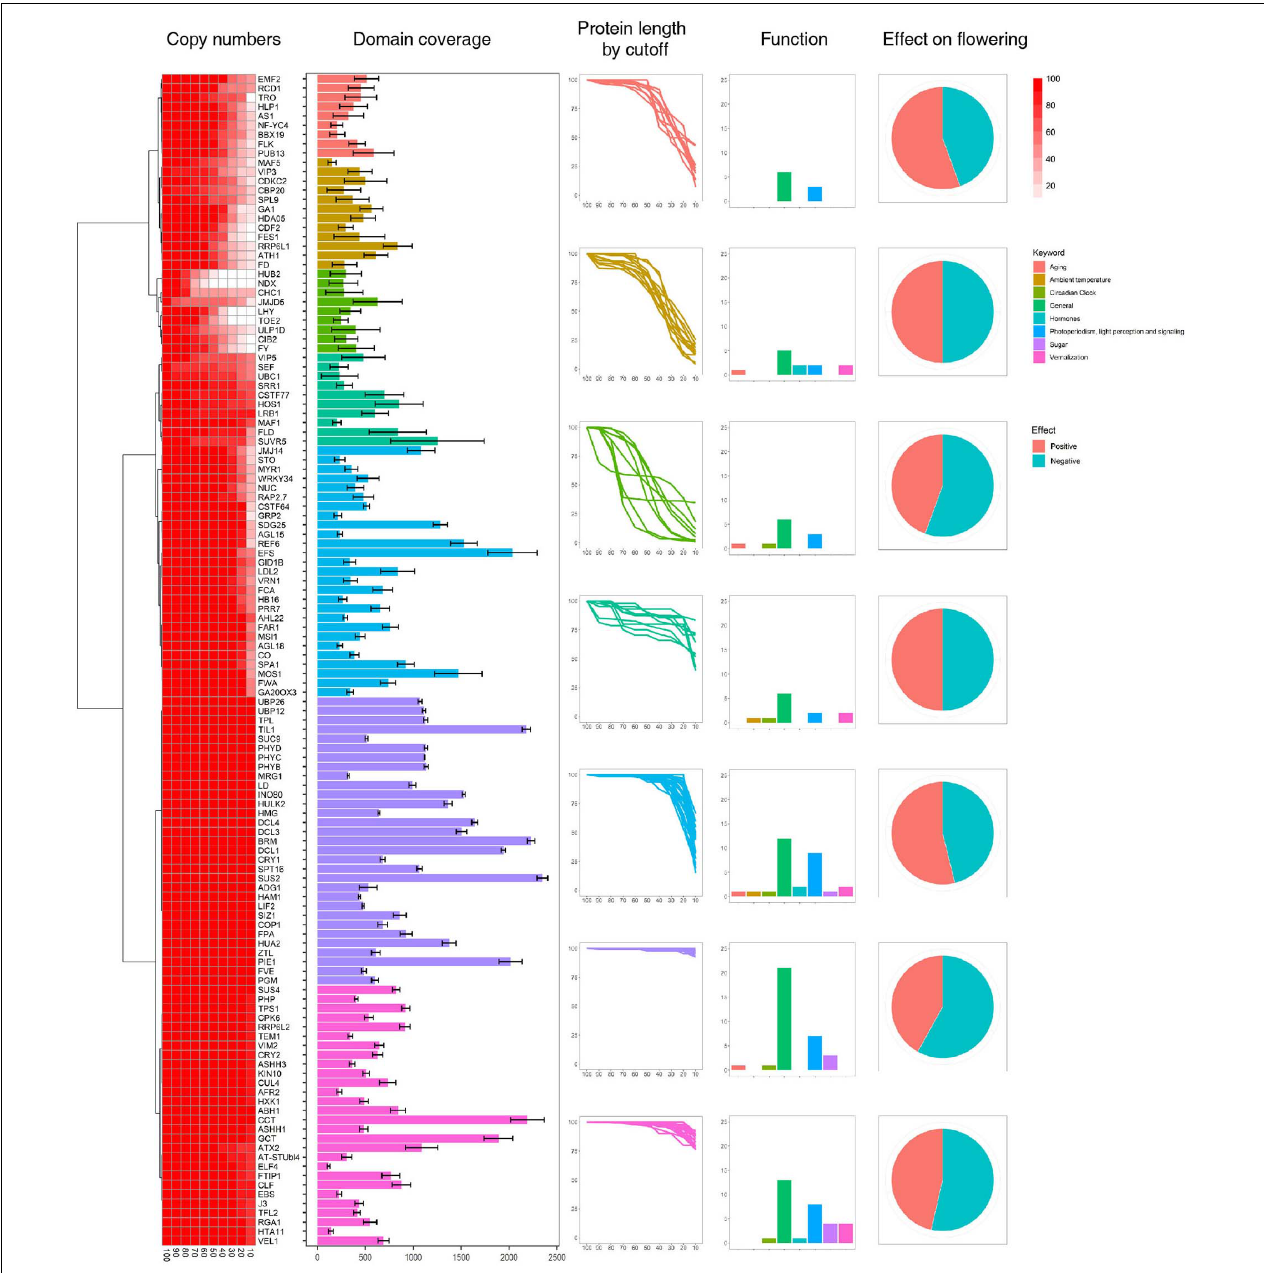
FIGURE 1 | Identification of flowering-time genes. Flowering-time genes were identified by their domain architectures, and domain coverage for each gene was calculated. Functions of flowering-time genes were predicted from the FLOR-ID